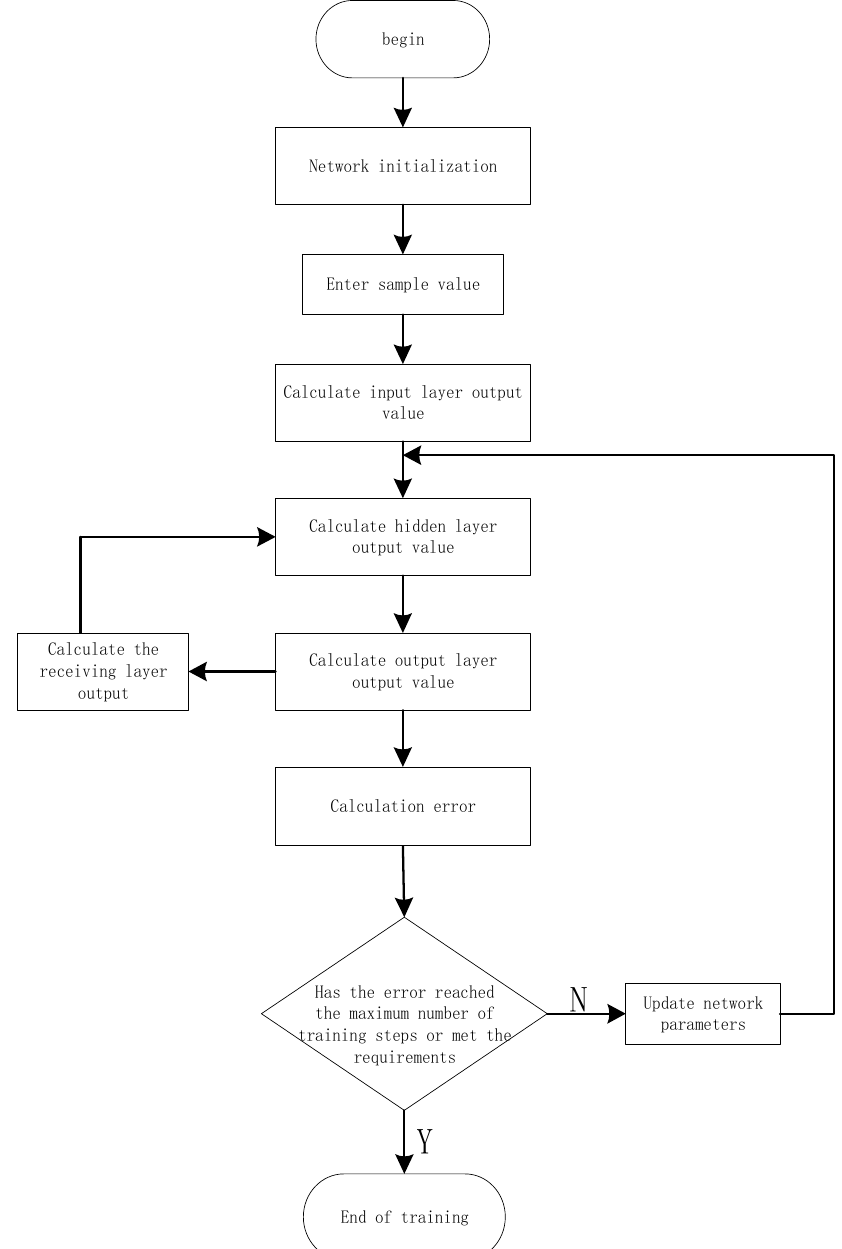
Figure 21. Training process of the Elman neural network. Using experimental data, Figure 22 compares the actual and predicted values, and Figure 23 shows the discrepancy between the two. As can be seen from Figure 23, most of the actual values are quite different from their, predicted counterparts, and only a few of the predicted values are close to the true values. Therefore, the performance of the prediction model based upon the Elman neural network is